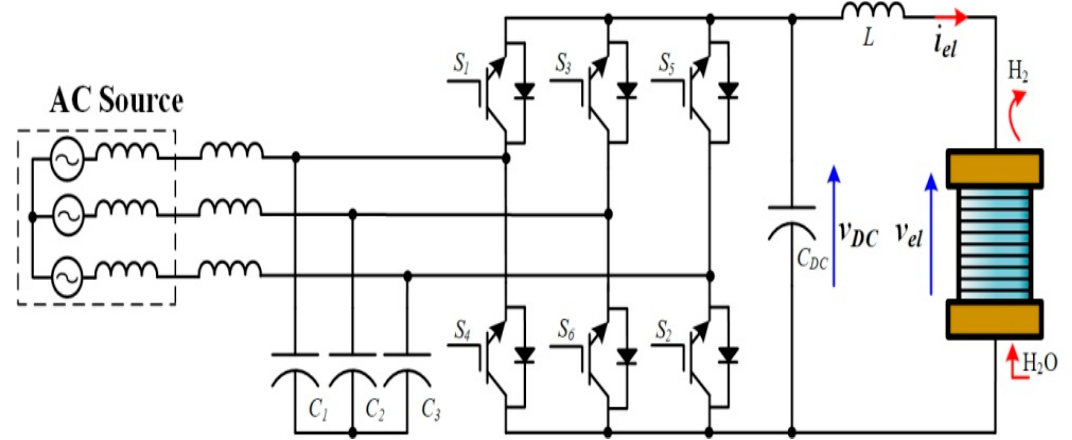
Figure 20. PWM current-source rectifiers for electrolyzer applications.